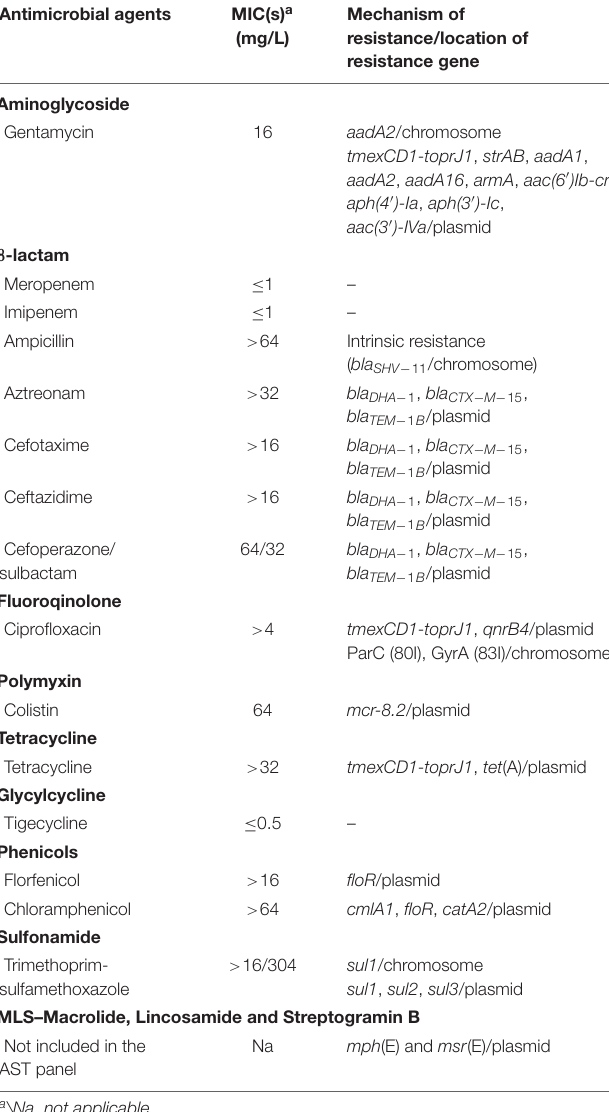
TABLE 1 | MICs and genetic characterization of K. pneumoniae T698-1. Antimicrobial